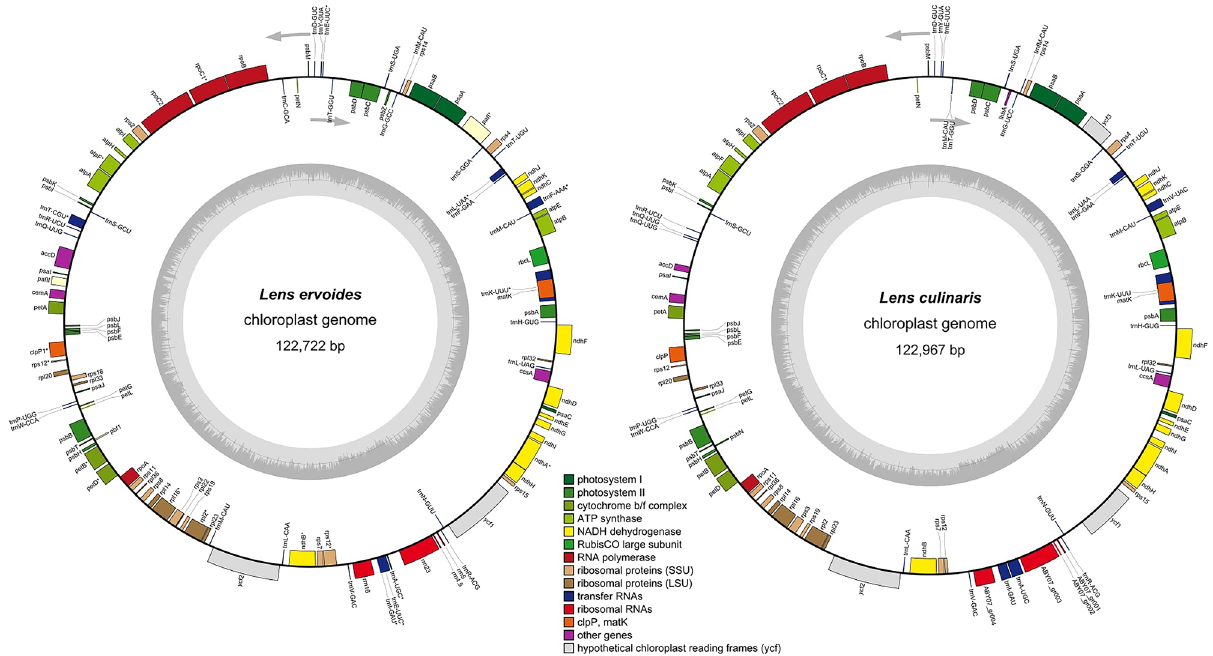
Figure 2. Gene maps of L. ervoides and L. culinaris . Genes inside the circle transcript clockwise, and genes outside the circle transcript counterclockwise. Genes with the same functional trait are shown in the same colour group. The dark grey area in the inner circle indicates the GC content of the corresponding genes, and the light grey area indicates the AT